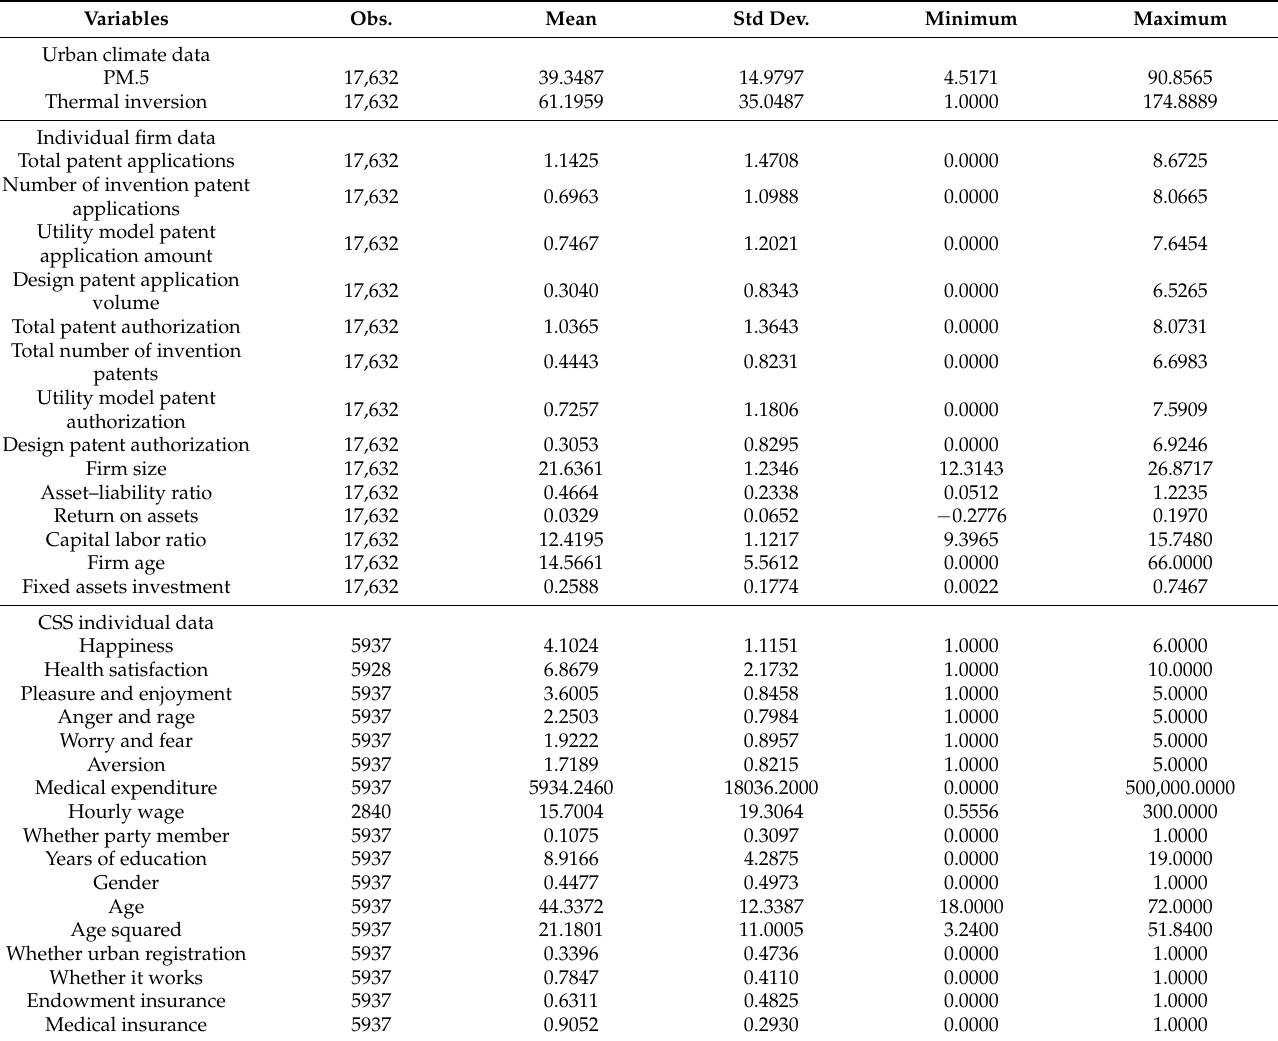
Table 1. Descriptive statistics of main